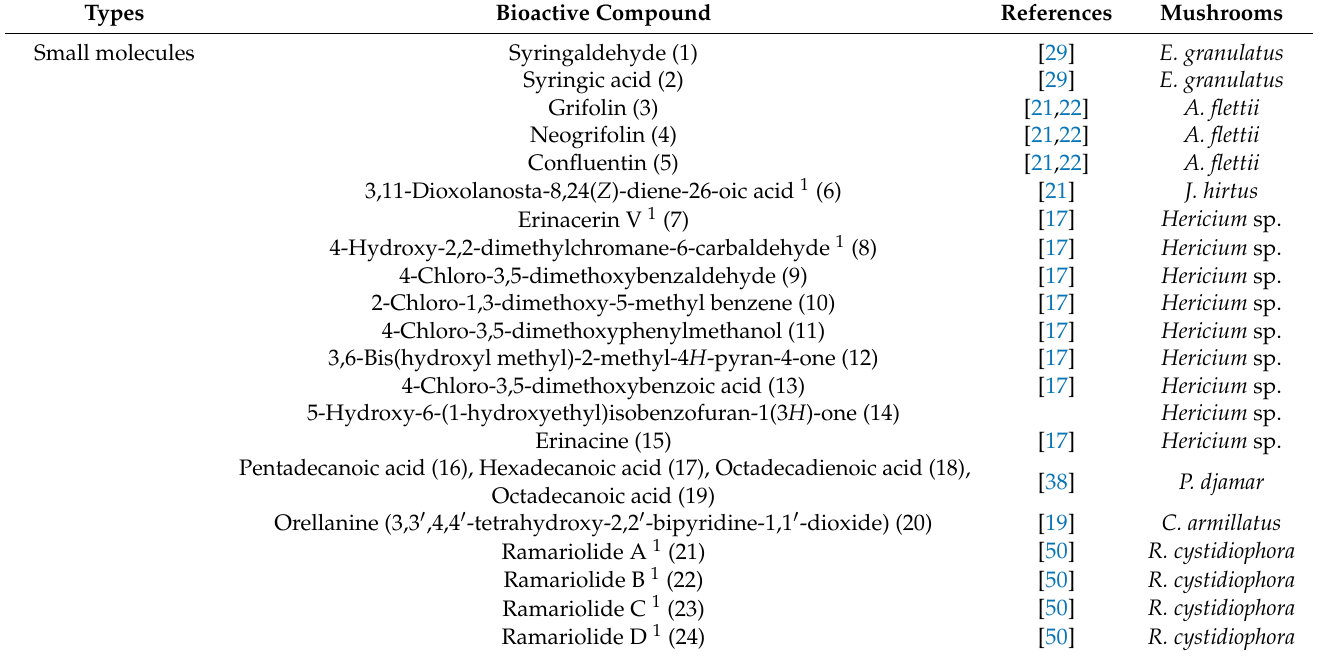
Table 2. Bioactive Molecules from Mushrooms Native to North